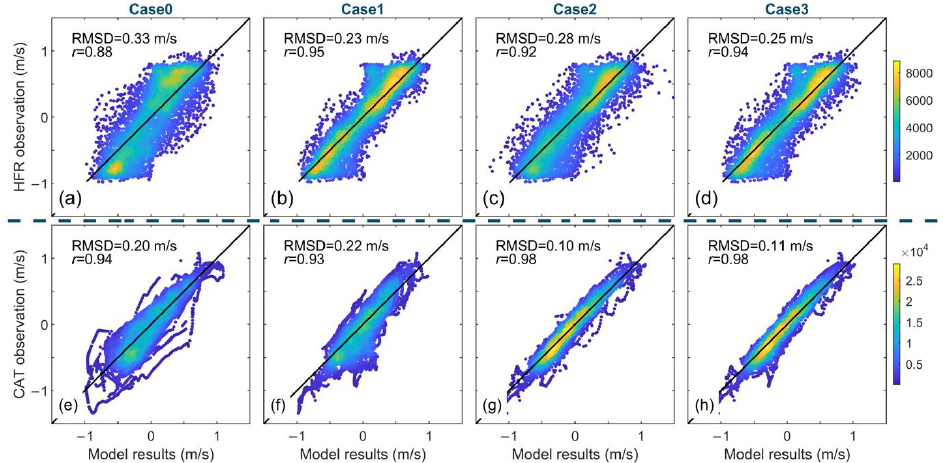
Figure 8. Scatterplot for ( a – d ) HFR radial velocities and ( e – h ) CAT section-averaged velocities against the model results. The RMSDs and correlation coefficients ( r ) between the observation and model data are shown in the upper-left corner of each panel. The color indicates the density of the data points.